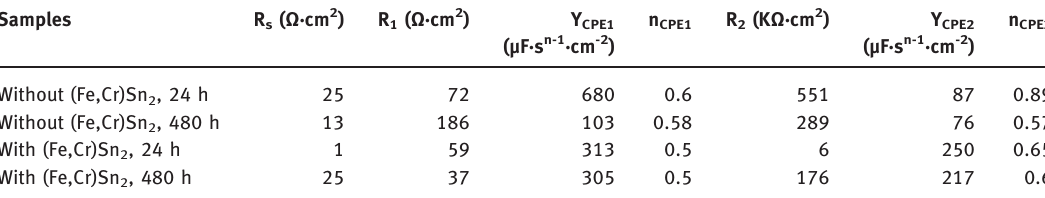
Table 3: Fitting parameters of electrochemical impedance spectra tests.